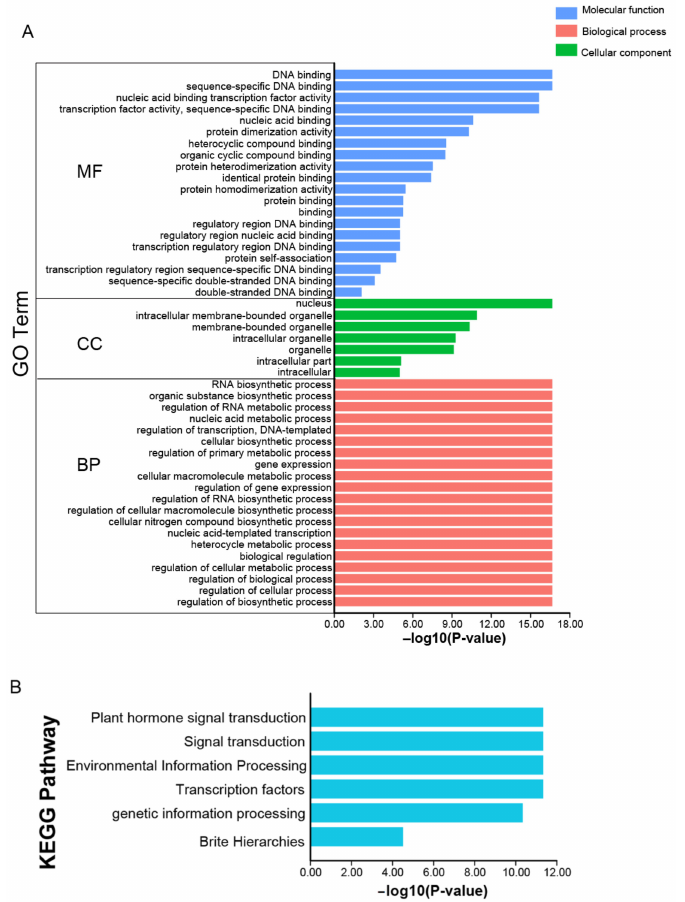
Figure 5. GO and KEGG enrichment of the JrbZIP genes. ( A ) GO enrichment of the JrbZIP genes. According to the secondary terminology, the GO annotation results are divided into three ontological categories and distinguished by different colors. ( B ) KEGG enrichment of the JrbZIP genes KEGG annotation results are represented by a blue bar